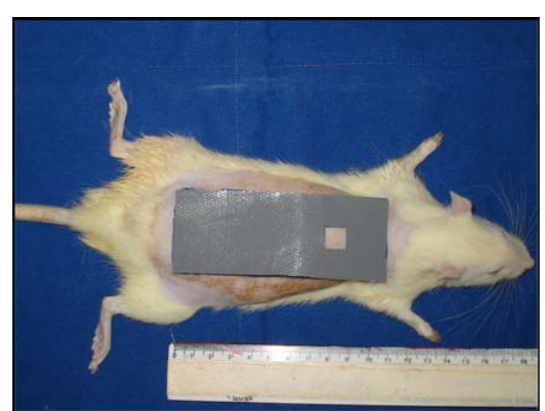
FIGURE 5 - Plastic template on the skin flap with the